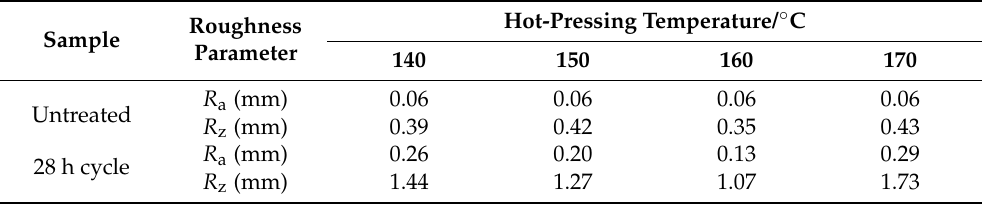
Figure 5. The deformation and cracks of cross-section and radial section of samples before and after the 28 h cycle test: ( a , b ) parenchyma cells in the cross-section, ( c , d ) parenchyma cells of ground tissue in the radial section, and ( e , f ) fibrocytes of vascular bundle in the radial section. Table 3. The roughness parameters of samples treated in different situations with various hot-pressing